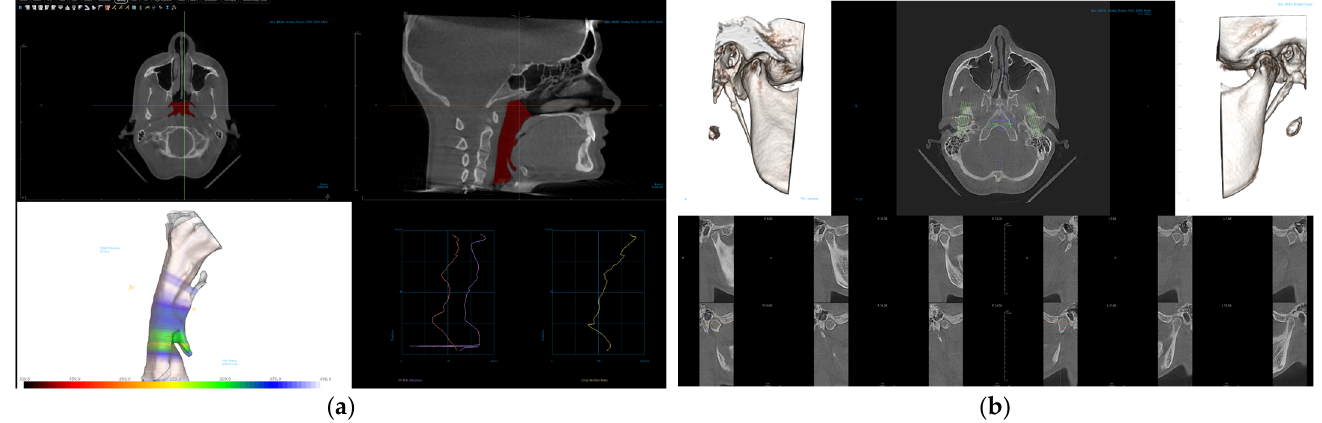
Figure 3. Various structures are now easily visualized by semiautomated software such as Invivo 7 Anatomage. ( a ) Passage of the airways; ( b ) temporomandibular joints. Anatomage. ( a ) Passage of the airways; ( b ) temporomandibular